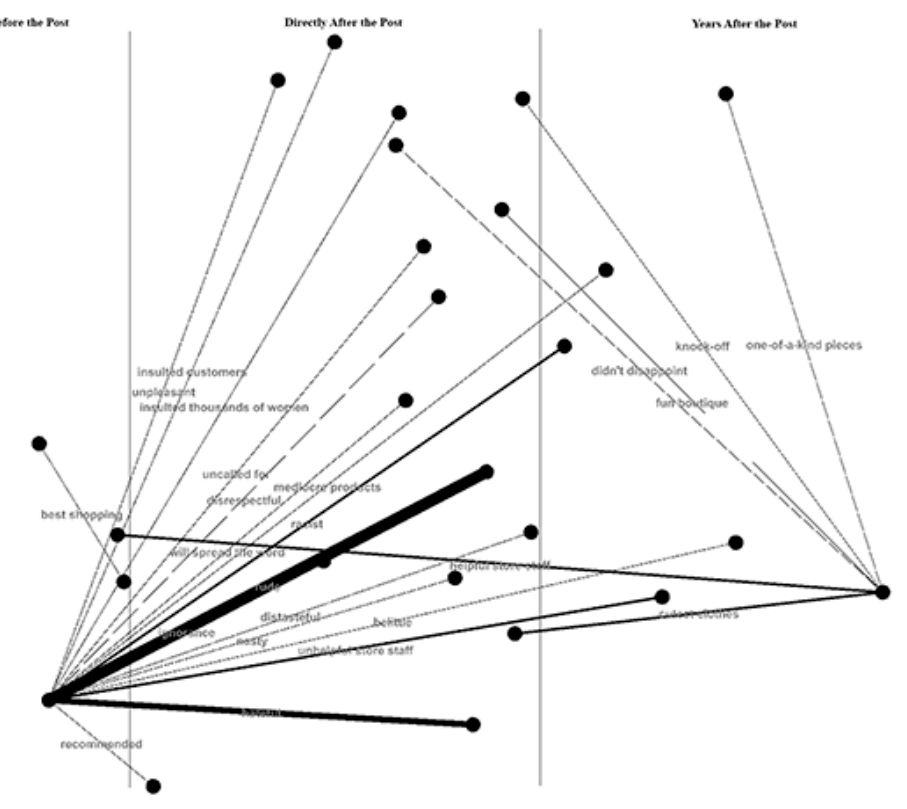
Figure 1. A semantic network.